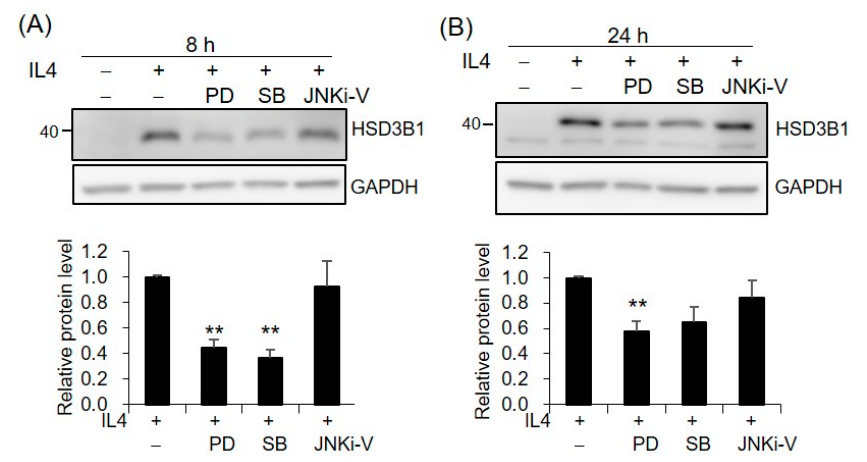
Figure 5. MAPKs are involved in IL4-induced HSD3B1 expression in HT-29 cells. The HT-29 cells were pretreated with MEK1/2 inhibitor PD98059 (10 μ M), p38 inhibitor SB202190 (2 μ M), or JNK inhibitor JNKi-V (5 μ M) for 30 min and exposed to IL4 (20 ng/mL) for 8 h ( A ) or 24 h ( B ). The HSD3B1 protein levels were analyzed by immunoblotting and quantified by normalizing the GAPDH levels. The values are represented as the means ± SEM of four independent experiments; ** p < 0.01.